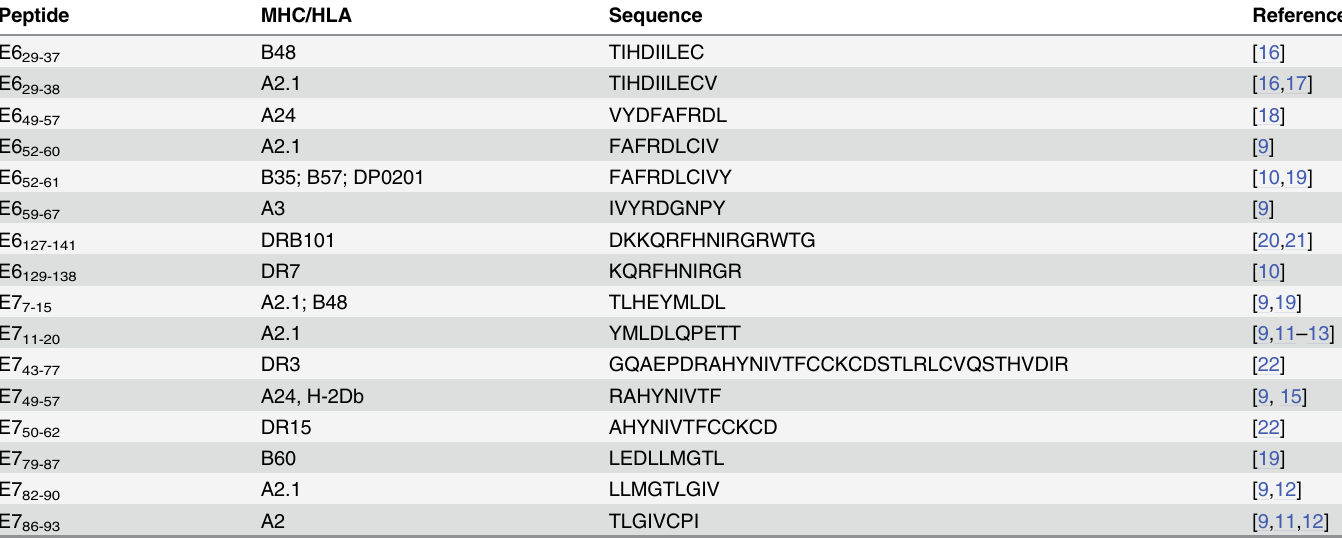
Table 1. E6 and E7 epitopes used to assemble in the E6E7 protein.